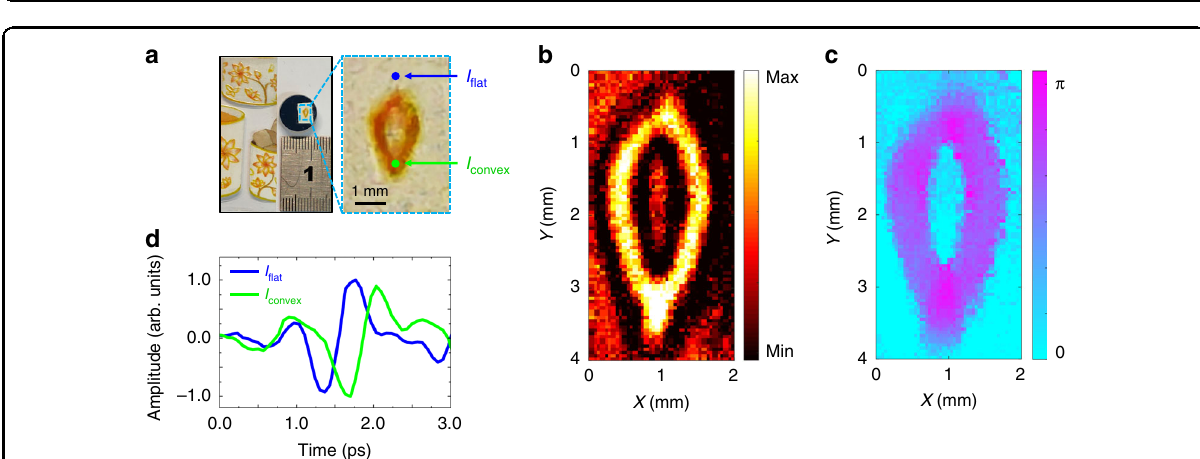
Fig. 5 THz near- fi eld imaging of a plastic pattern. a Plastic pattern, its petal-shaped region, and a ruler. The magni fi ed view shows the petal shape, which was approximately 1.1 mm × 2.7 mm. Positions of the THz signals I fl at and I convex are marked by blue and green points on the fl at and convex regions of the petal. d THz temporal I fl at and I convex signals. Intensity and phase images of the petal at 0.7 THz are presented in b and c , respectively